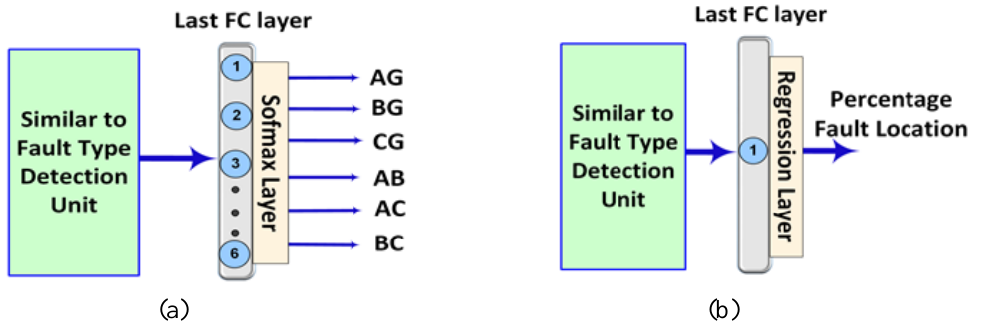
Figure 6. Schematic diagram of ( a ) the fault classification unit and ( b ) the fault location estimation unit.